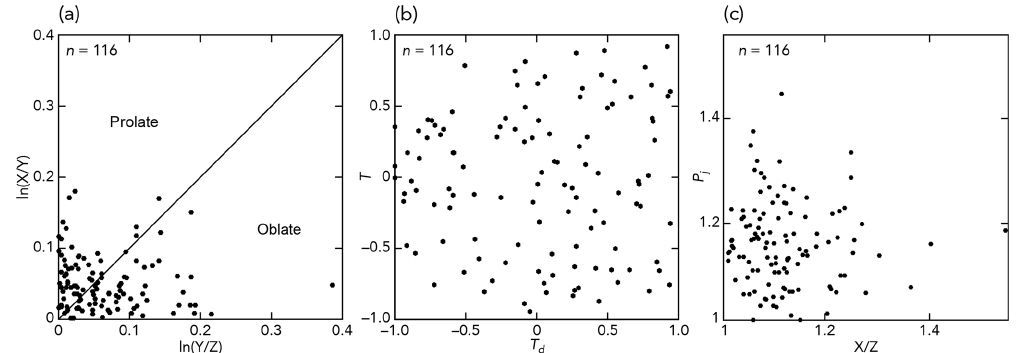
Figure 12. Comparison of shape parameters for specimen cubes and AMS ellipsoids. (a) Flinn diagram of specimen dimensions shows that cubes are not perfectly isometric. (b–c) Specimen shape does not seem to exert an influence on either shape or degree of magnetic